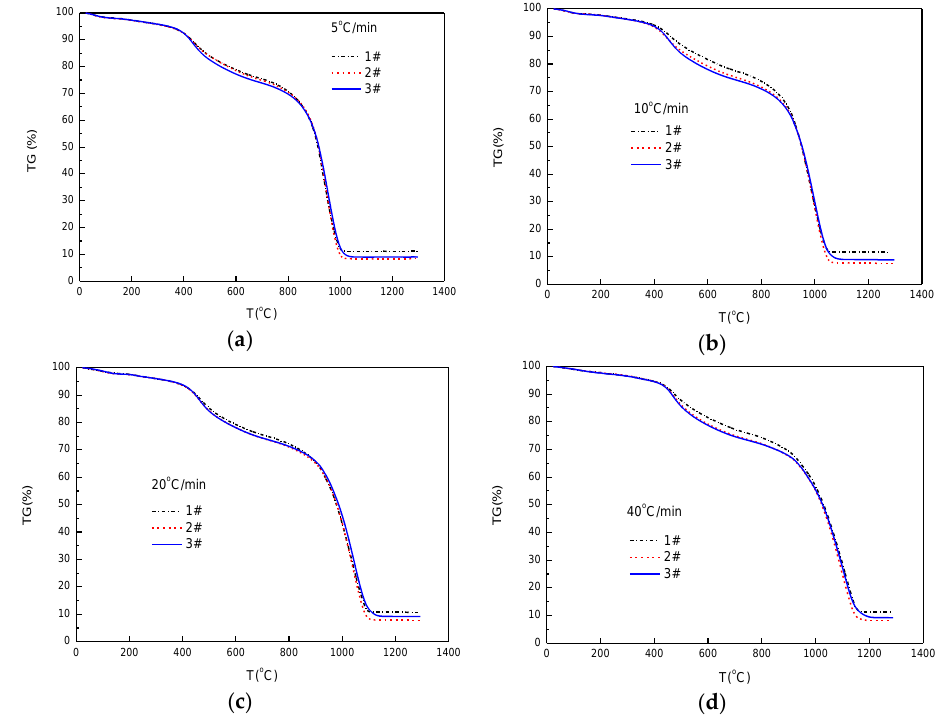
Figure 3. TG curves of coal samples with different particle sizes: “(a) 5 K/min, (b) 10 K/min, (c) 20 K/min, and (d) 40